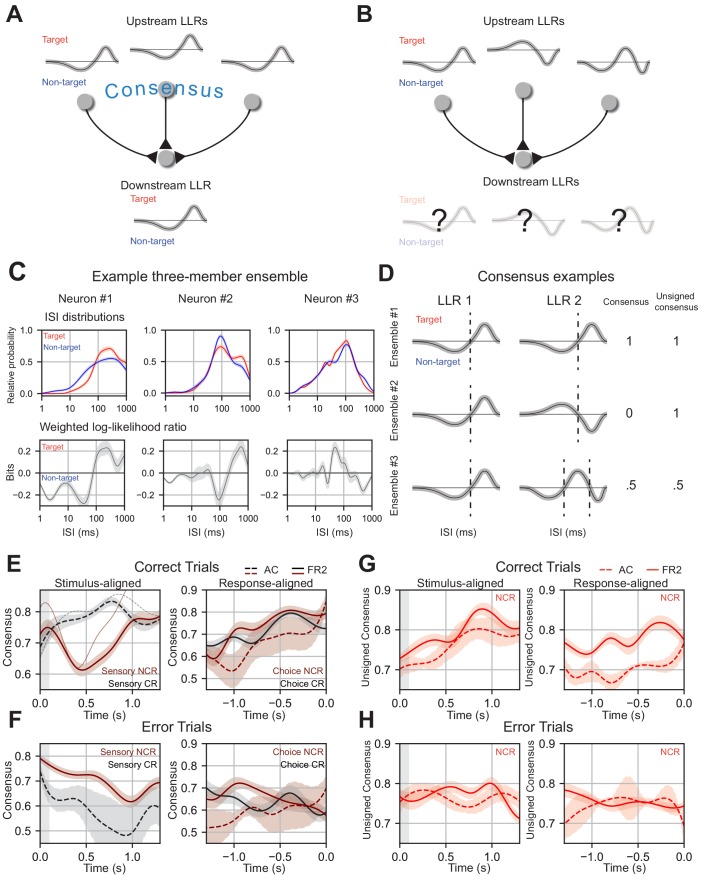
.Ensemble consensus-building during behavior. (A) Schematic of consensus building in a three-member ensemble. When the LLRs of ensemble members are similar the meaning of any ISI is unambiguous to a downstream neuron. (B) Schematic of a three-member ensemble without consensus. The meaning of an ISI depends on the upstream neuron it originates from. (C) ISI distributions, and LLRs for three members of a sample ensemble. Note that despite differences in ISI distributions, neuron #1 and neuron #2 have similar weighted log-likelihood ratios (ISIs > 200 ms indicate target, ISIs < 200 ms indicate non-target). (D) Consensus values for three illustrative two-member ensembles. Ensemble 1 members have identical LLRs, agreeing on the meaning of all ISIs (consensus = 1) and on how the ISIs should be partitioned (unsigned consensus = 1). Ensemble 2 contains cells with LLRs where the ISI meanings are reversed, disagreeing on meaning of the ISIs (consensus = 0) but still agree on how the ISIs should be partitioned (unsigned consensus = 1). Ensemble 3 contains two cells with moderate agreement about the ISI meanings and partitioning, leading to intermediate consensus and unsigned consensus values (0.5 for each). (E) Left, mean consensus as a function of time from tone onset (stimulus-aligned) on correct trials for three-member sensory classically responsive ensembles in AC (two or more members sensory classically responsive; black dotted line; n=11 ensembles) and sensory non-classically responsive ensembles in FR2 (two or more members sensory non-classically responsive; dark red solid line; n=101 ensembles). Standard deviation shown around each mean trendline. Thin solid and dotted line represent an individual consensus trajectory from FR2 and AC, respectively. FR2 sensory non-classically responsive cells consistently reached consensus and then diverged immediately after stimulus presentation (Δconsensus, t = 0 to 0.42 s, pSNR = 3.9×10−4 Wilcoxon test with Bonferroni correction, two-sided). AC classically responsive ensembles (black) increase consensus until 750 ms (Δconsensus, t = 0 to 0.81 s, pSR = 0.14 Wilcoxon test with Bonferroni correction, two-sided). Right, mean consensus as a function of time to behavioral response (response-aligned) on correct trials for three-member choice classically responsive ensembles (two or more members choice classically responsive; black) in FR2 (solid line; n=47 ensembles) and choice non-classically responsive (two or more members choice non-classically responsive; dark red) in AC (dotted line; n=11 ensembles) and FR2 (solid line; n=57 ensembles). Standard deviation shown around each mean trendline. On correct trials, choice classically responsive (black) and choice non-classically responsive ensembles (dark red) in both regions reached high consensus values ~500 ms before response (Δconsensus, t = -1.0 to 0.0 s, pCNR = 2.0×10−5, pCR = 0.12 Wilcoxon test with Bonferroni correction, two-sided). (F) As in e, but for error trials (Δconsensus, correct vs. error trials, stimulus: pSNR= 0.007, pSR = 0.065, choice: pCNR = 0.0048, pCR = 0.065 Mann-Whitney U test, two-sided). (G) Unsigned consensus index for non-classically responsive ensembles (two or more members non-classically responsive) in AC (dotted line; n=13 ensembles) and FR2 (solid line; n=36 ensembles), stimulus-aligned (left, Δconsensus, t = 0 to 0.89 s, p = 5.1×10−5 Wilcoxon test with Bonferroni correction, two-sided) and response-aligned (right, Δconsensus, t = -1.0 to 0.0 s, p = 0.0033 Wilcoxon test with Bonferroni correction, two-sided). On correct trials, ensembles reach high values of unsigned consensus ~750 ms after tone onset and within 500 ms of behavioral response. (H) As in (G), but for error trials (Δconsensus, correct vs. error trials, p = 1.9×10−9 Mann-Whitney U test, two-sided). (E) – (G) Combinations analyzed and shown are those for which there are significant numbers in our dataset.